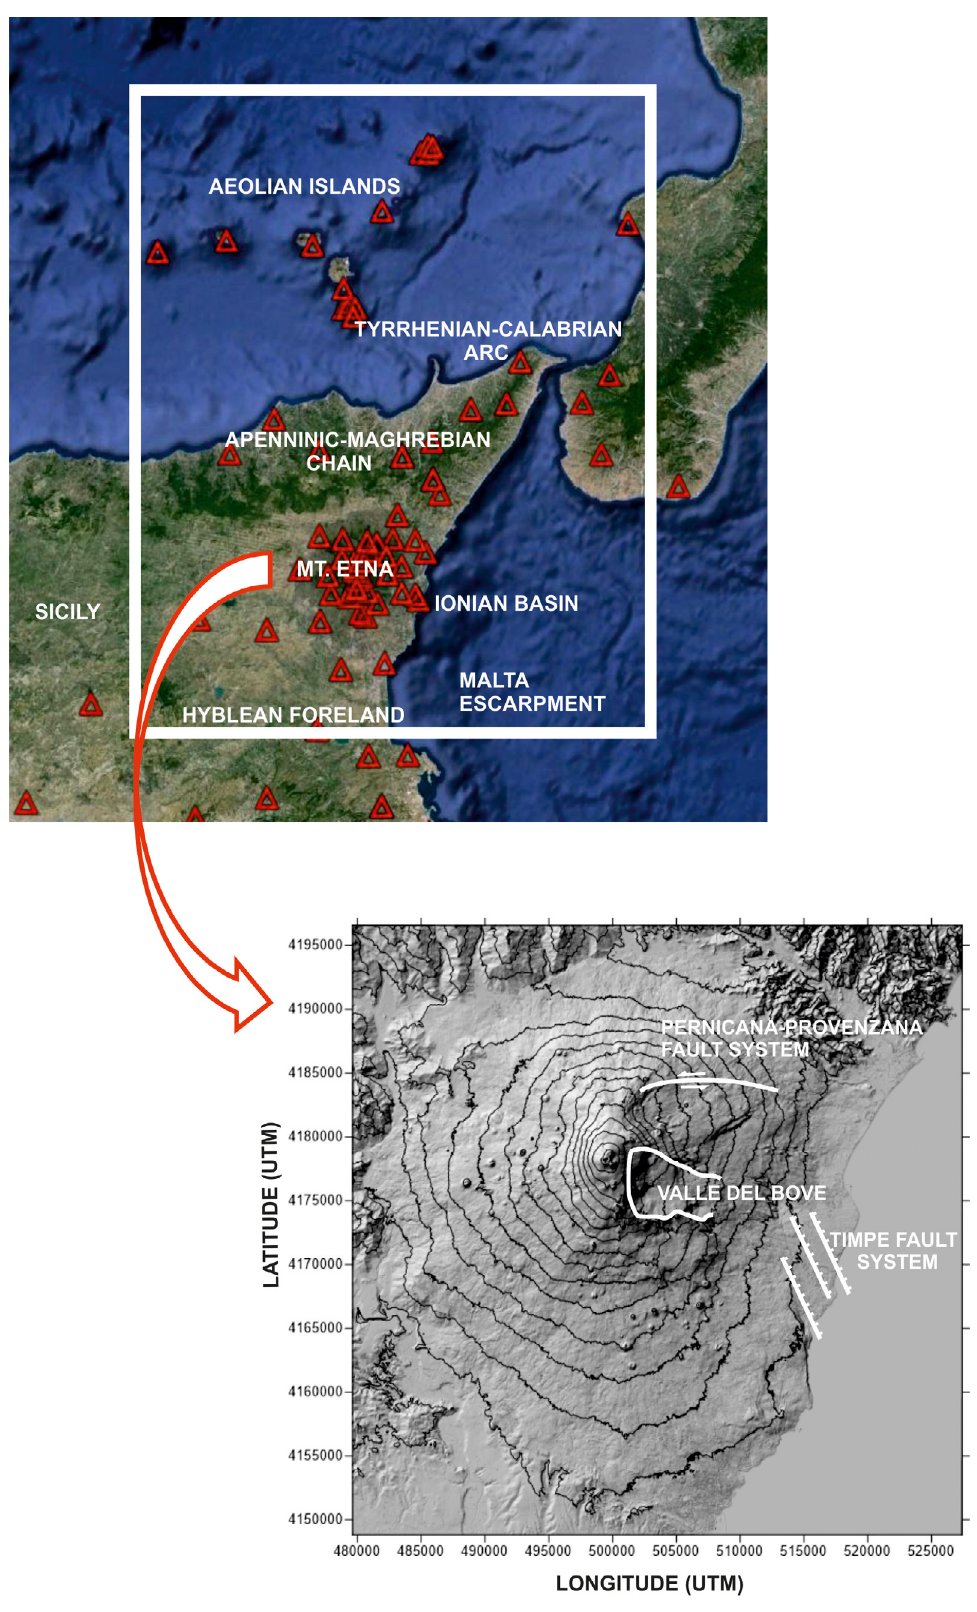
Figure 1. Maps of the area under study in the TOMO-ETNA experiment. Triangles mark the position of the seismic stations of the per- manent network of the INGV, Italy. Map was obtained using free Google Earth